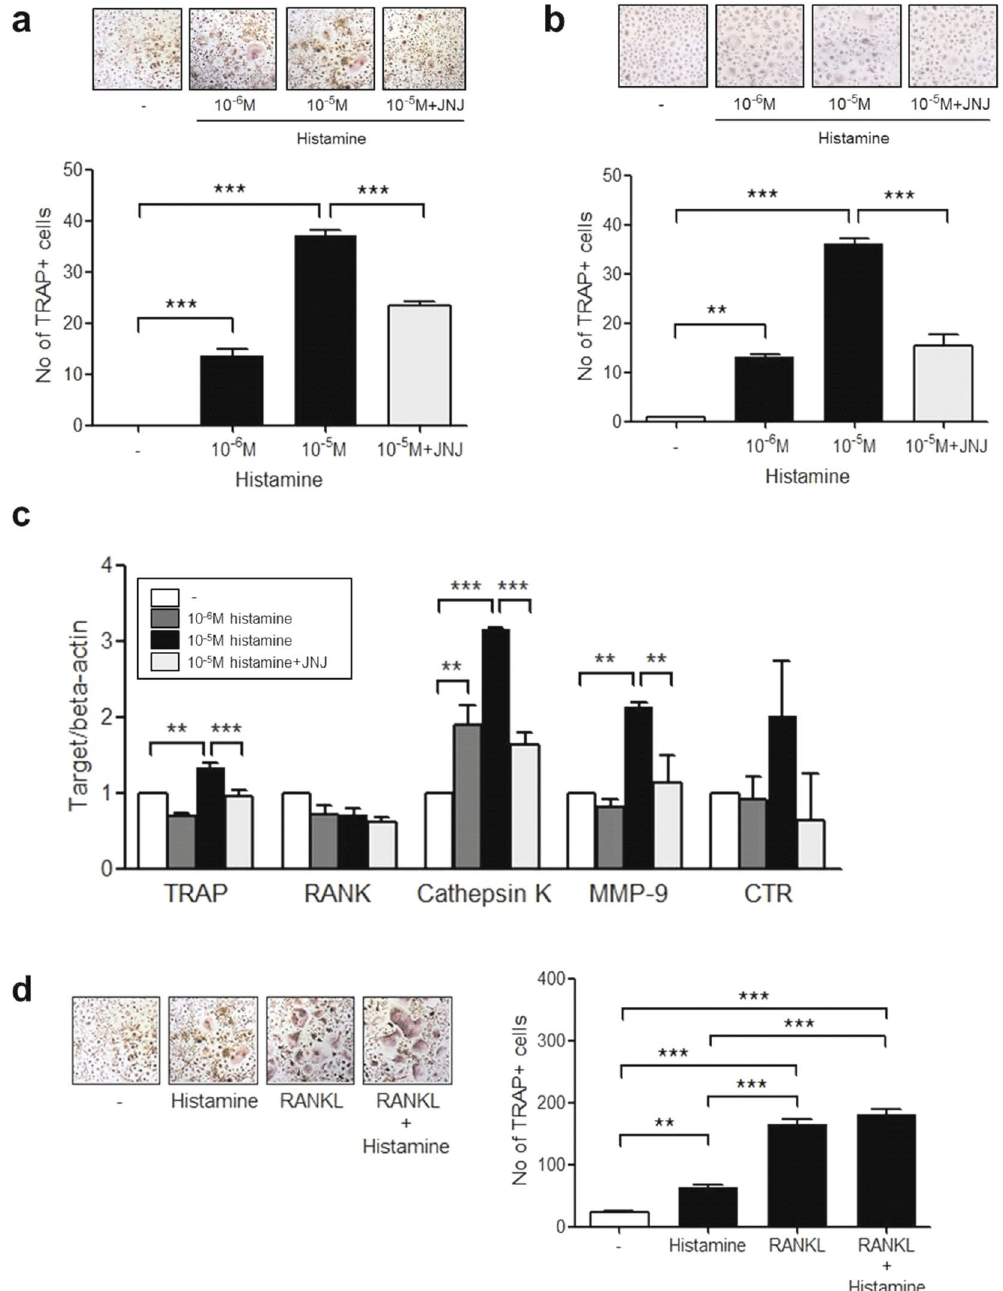
Figure 5. Histamine-induced osteoclast differentiation in PB monocytes and the inhibitory effect of H4R antagonist in RANKL-induced osteoclastogenesis. ( a ) CD14 + monocytes isolated from PB of HC were cultured with 0–10 − 5 M of histamine and 10 μ M of JNJ7777120 in the presence of 25 ng/ml of M-CSF. After 21 days of culturing, TRAP-positive multinucleated cells were counted. The figures represent one of 3 independent experiments. ( b ) CD14 + monocytes isolated from PB of 3 RA patients were cultured with 0–10 − 5 M of histamine and 10 μ M of JNJ7777120 in the presence of 25 ng/ml of M-CSF. After 21 days of culturing, TRAP-positive multinucleated cells were counted. The figures represent one of three independent experiments. ( c ) CD14 + monocytes were cultured with 0–10 − 5 M of histamine and 10 μ M of JNJ7777120 in the presence of 25 ng/ml M-CSF and the mRNA expression of osteoclast markers such as TRAP, RANK, cathepsin K, MMP-9 and CTR was determined using real-time PCR. ( d ) CD14 + monocytes were cultured with 10 ng/ml of RANKL, 10 − 5 M histamine, and RANKL with histamine in the presence of 25 ng/ml of M-CSF. After 21 days of culturing, TRAP- positive multinucleated cells were counted. The figures represent one of three independent experiments. The data represent the mean ± SEM of three independent experiments. ** P < 0.01 and *** P < 0.001. TRAP; tartrate-resistant acid phosphatase, JNJ; JNJ7777120, RANK; receptor activator of nuclear factor- κ B, MMP-9; matrix metalloproteinase-9, CTR; calcitonin